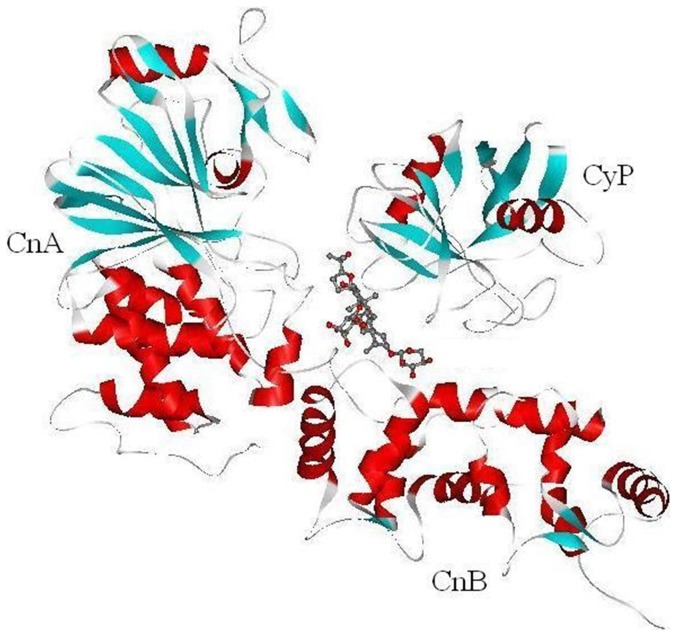
INVDOCK-predicted binding model of AGS-IV molecule (shown in ball and stick model) with cyclophilin (Cyp) and calcineurin (Cn).CnA and CnB are the catalytic subunit and the calcium-binding regulatory subunit of calcineurin, respectively. In the protein secondary structure, red, blue and grey colors represent alpha-helices, beta-sheets and loops, respectively; for the ligand structure, red and grey colors correspond to oxygen and carbon atoms, respectively.